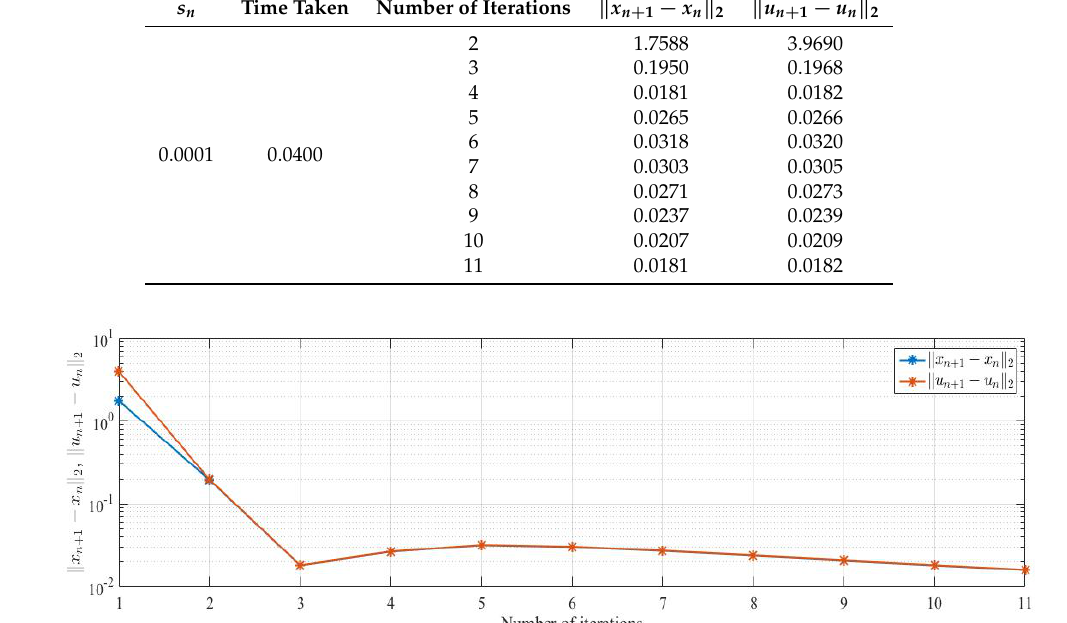
Figure 2. Example 1, case